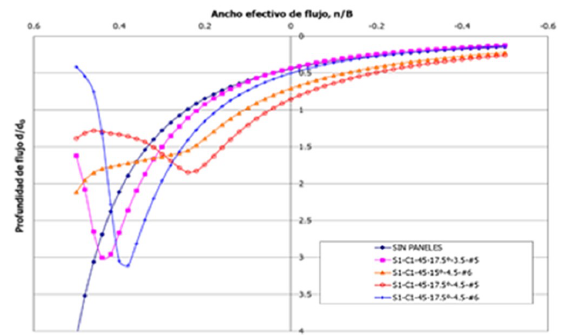
Figure 19. Cauca River, Guarumo: results of the BVANE program (Odgaard [10]) for the selection of the optimal solution with vanes using subsector 1, Stage I, as an example.